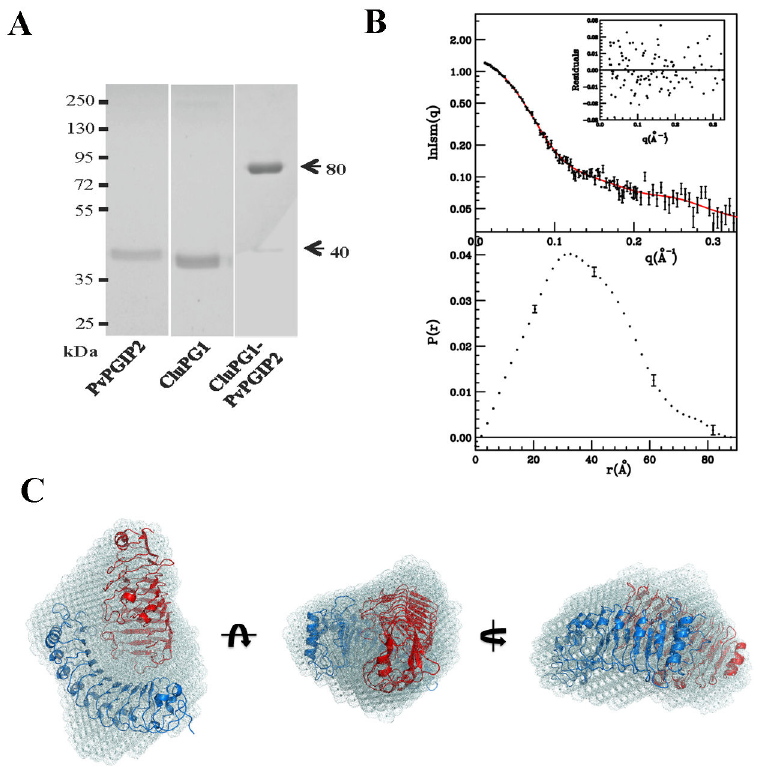
Figure 1. Analyses on the cross-linked complex formed by CluPG1 and PvPGIP2. A, SDS-PAGE analysis on the CluPG1- PvPGIP2 cross-linked complex. B, SAXS analysis on CluPG1-PvPGIP2 cross-linked complex: experimental scattered intensities (dots) and the calculated ones (line) are shown in the top panel. The residuals are reported in the inset and the corresponding p(r) function is shown in the bottom panel. For clarity only a few error bars are shown. C, Three-dimensional structure of the cross-linked complex between CluPG1 (in red) and PvPGIP2 (in blue) obtained with the SASREF program superimposed to the consensus envelope calculated by the GA_STRUCT program. Three orthogonal viewpoints are